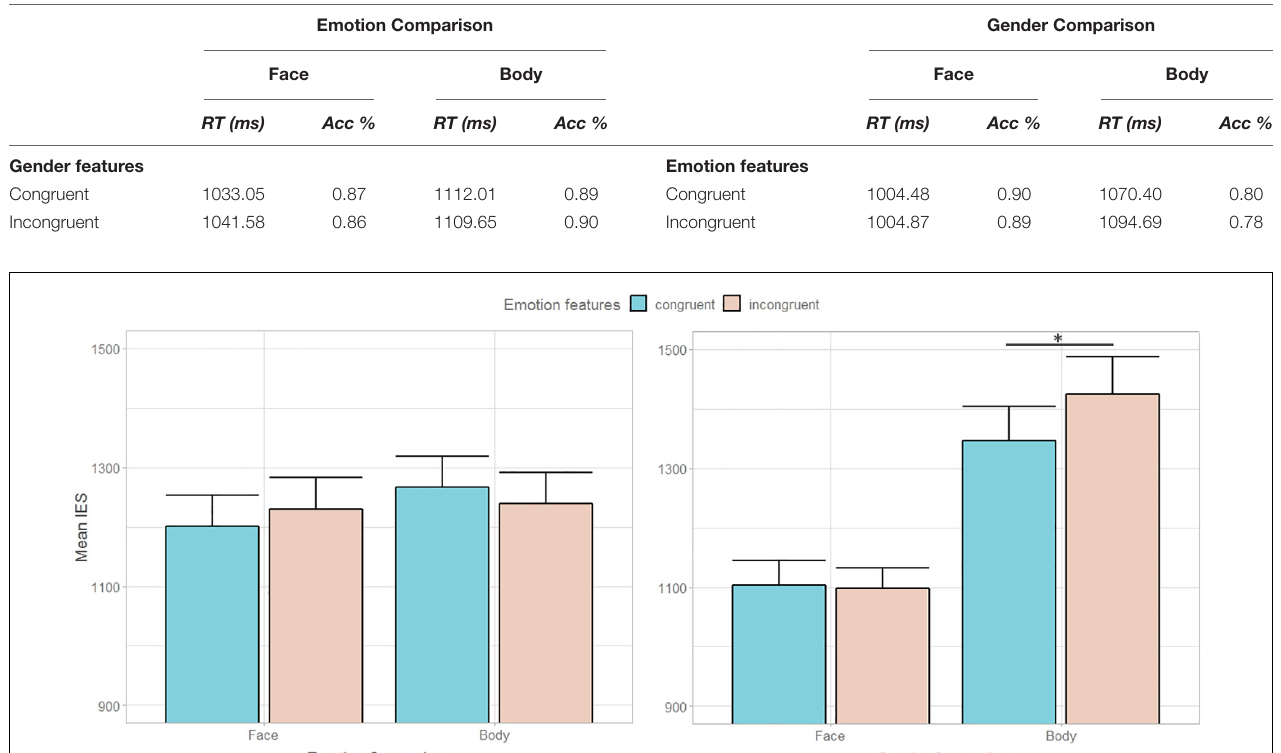
TABLE 2 | Mean RTs and Accuracy for each experimental condition in Experiment 2.